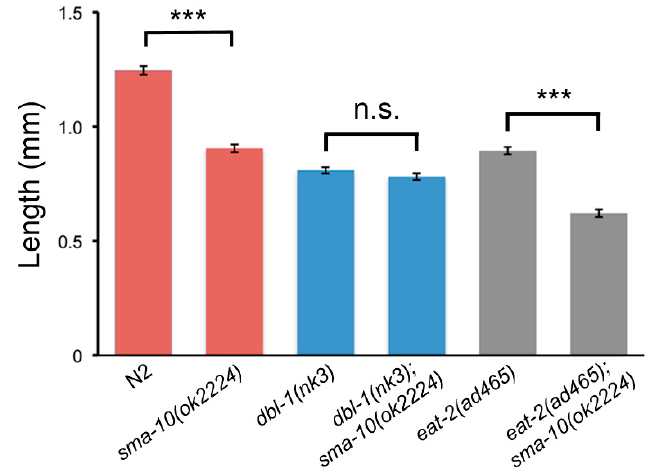
Figure 1. Adult body length of N2, sma-10(ok2224) , dbl-1(nk3) , dbl-1(nk3);sma-10(ok2224) , eat-2(ad465) and eat-2(ad465);sma-10(ok2224) worms. At least 20 animals from a minimum of two independent experiments were synchronised and measured as described in Methods, and its final length were plot. Error bars indicate 95% confidence intervals. Not significant (n.s.) and significant statistical differences (*** p < 0.001) are indicated.